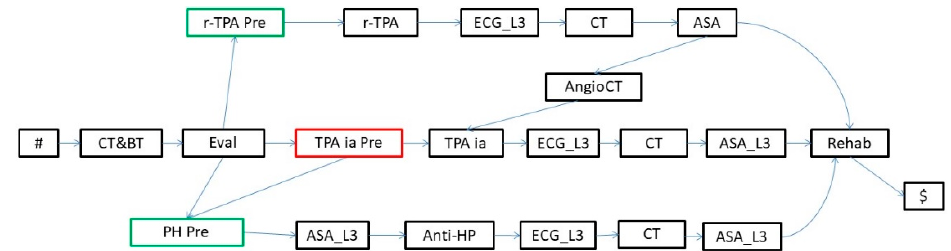
Figure 12. Process model interactively abstracted at level 3 with a different strategy.